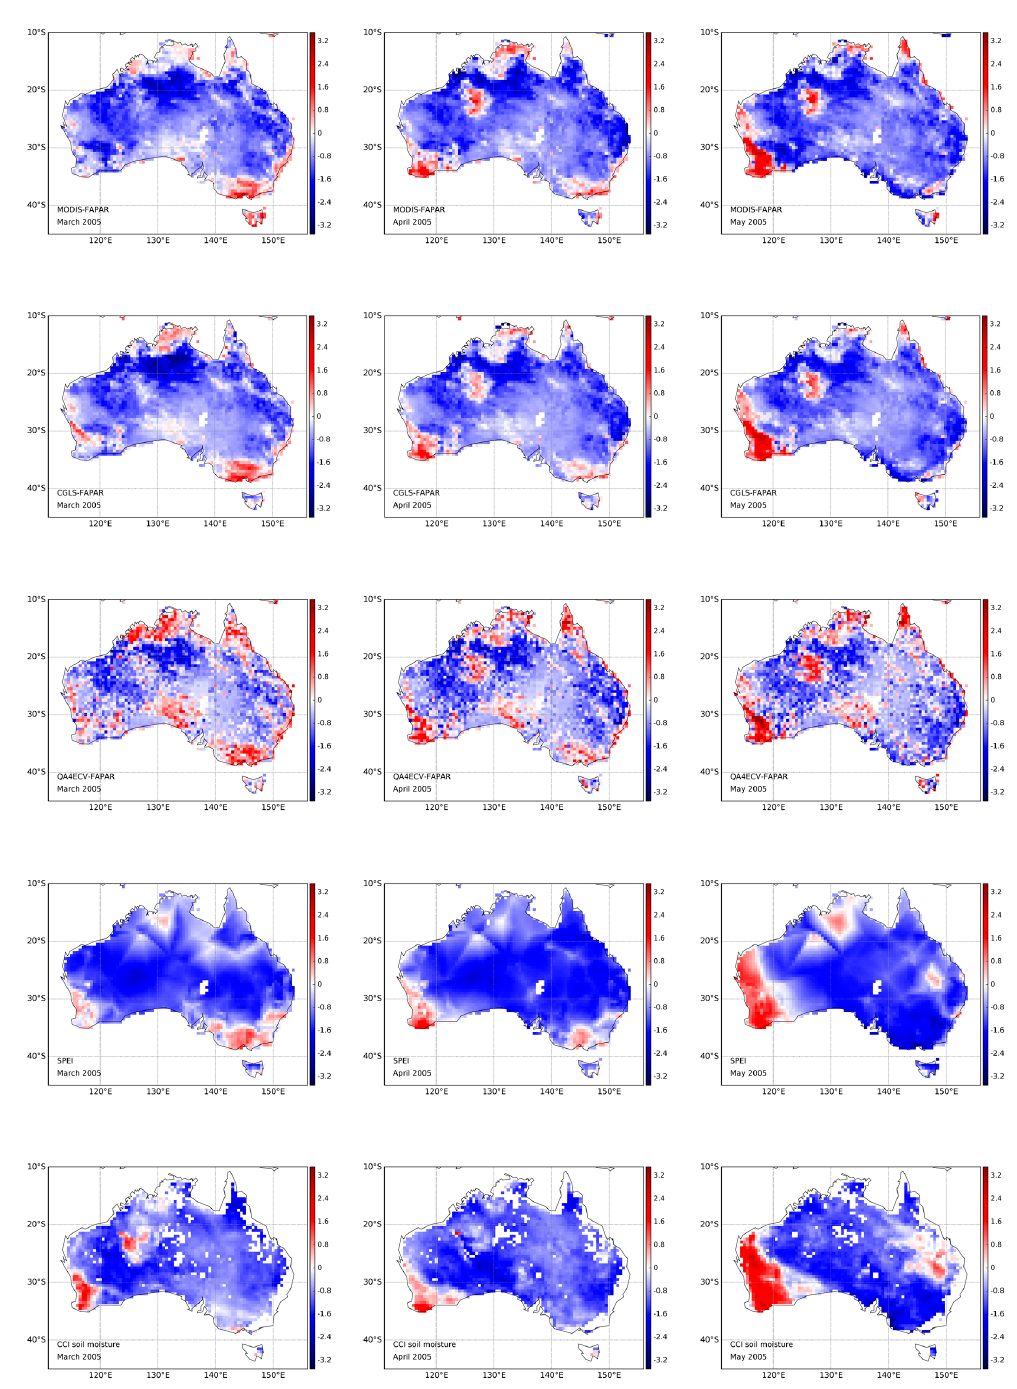
Figure 8. Temporal variation of spatially distributed FAPAR, CCI soil moisture standardized anomaly, and SPEI ( rows ) over Australia from March to May ( columns ) in